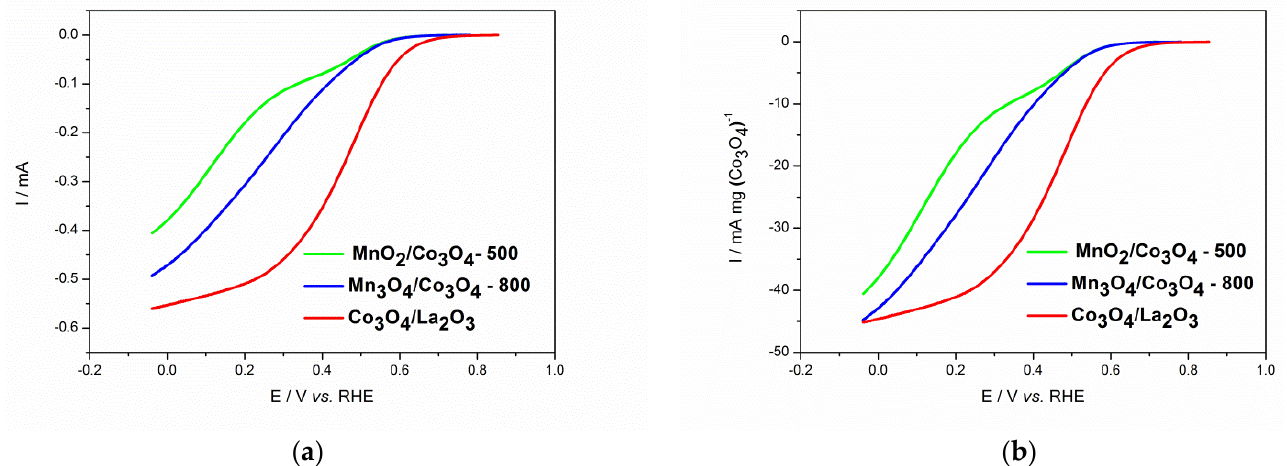
Figure 8. Comparison of ( a ) synthesized materials in mA ( b ) calculated per mass of Co.